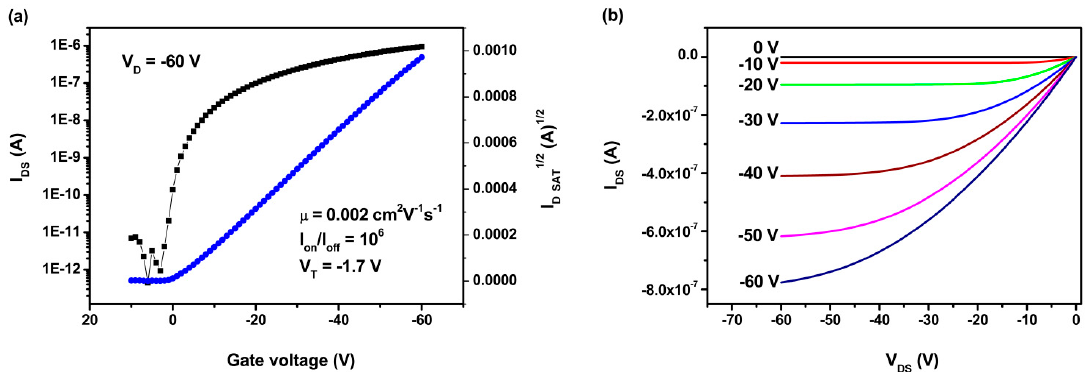
Figure 4. Transfer ( a ) and output ( b ) characteristics of PSTDPP.